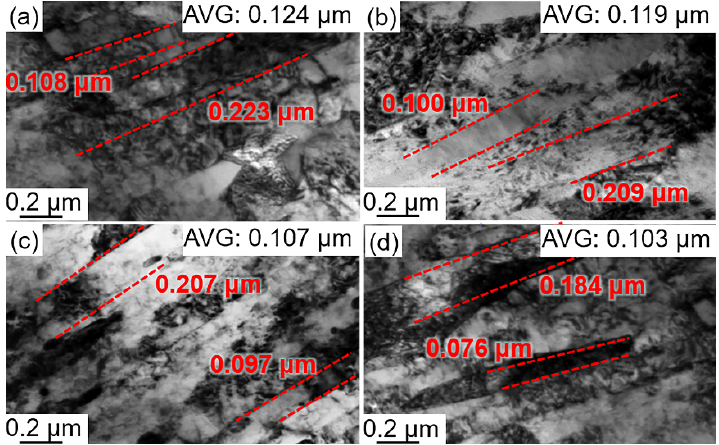
Figure 8. TEM micrographs of ( a ) Q, ( b ) D 5min , ( c ) D 5h , and ( d ) D 12h (AVG: average value). Table 4. The size of martensite block ( d b ) and martensite lath ( d l ) under different heat treatments.